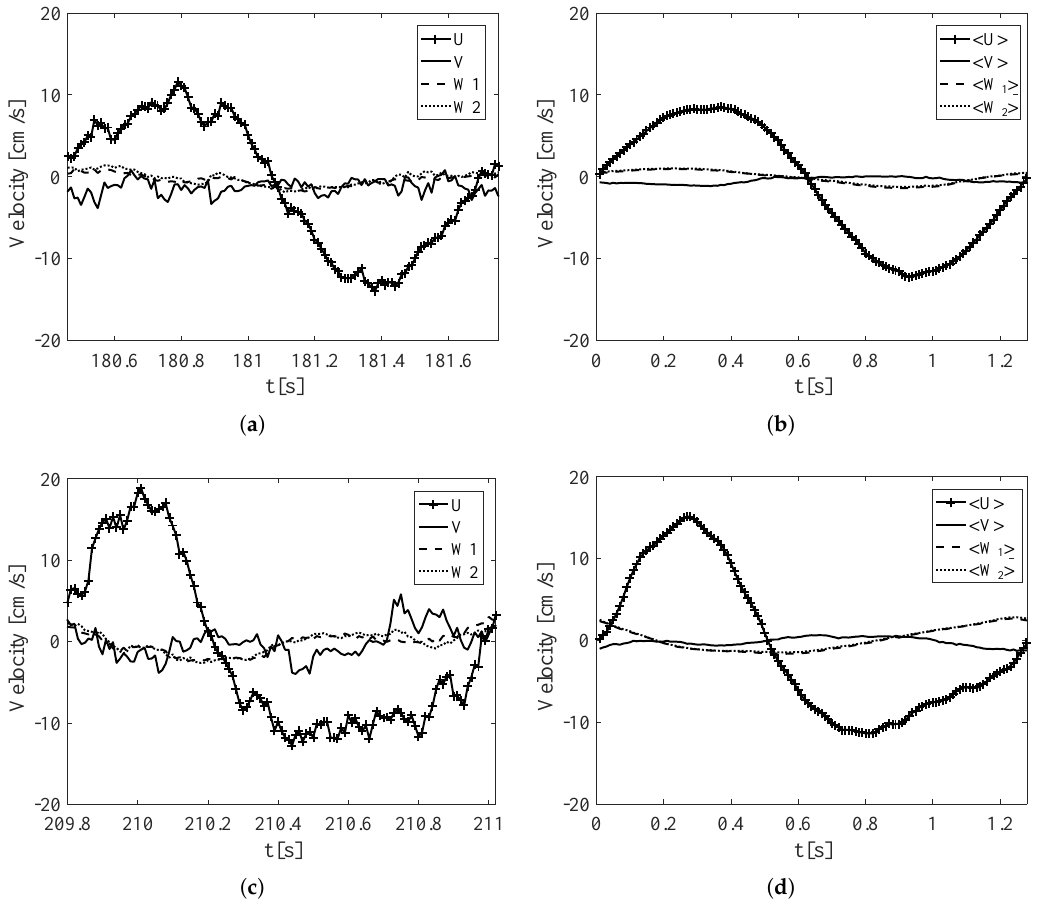
Figure 3. T 9 test ( H = 0.06 m, T = 1.26 s), velocities measured at location L 2 , at the elevation z / d = 0.10: ( a ) Vectrino Profiler velocity just after the transient condition at P 1 ; ( b ) phase averaged velocity at P 1 ; ( c ) Vectrino Profiler velocity at P 2 ; and ( d ) phase averaged velocity at P 2